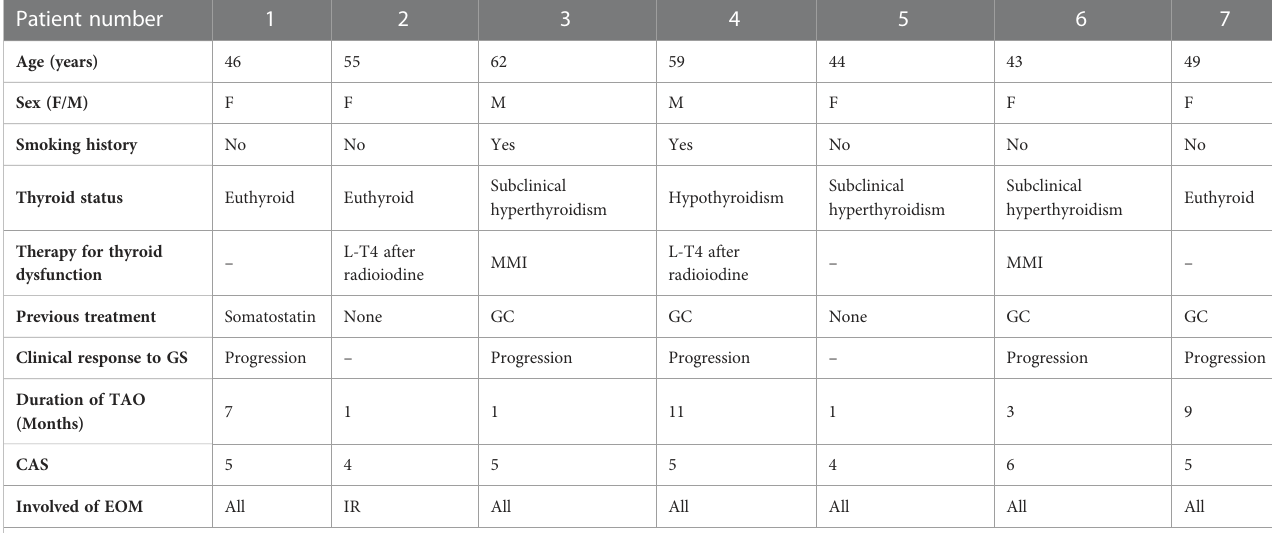
TABLE 1 Demographics and clinical characteristics of seven patients treated with